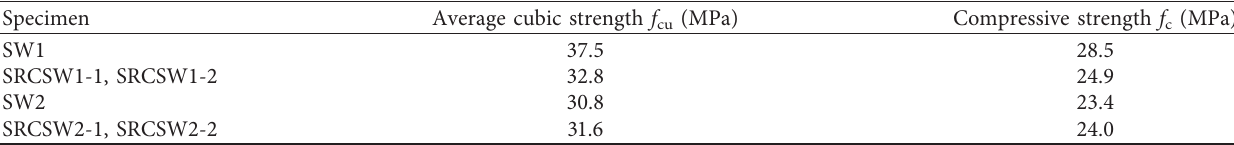
Table 1: Material properties of concrete.